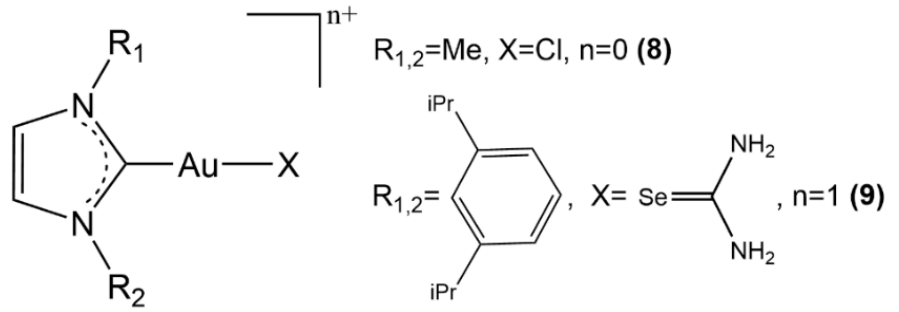
Figure 6 . Gold(I) complexes with NHC carbenes ( 8 , 9 ). Figure 6. Gold(I) complexes with NHC carbenes ( 8 , 9 ).